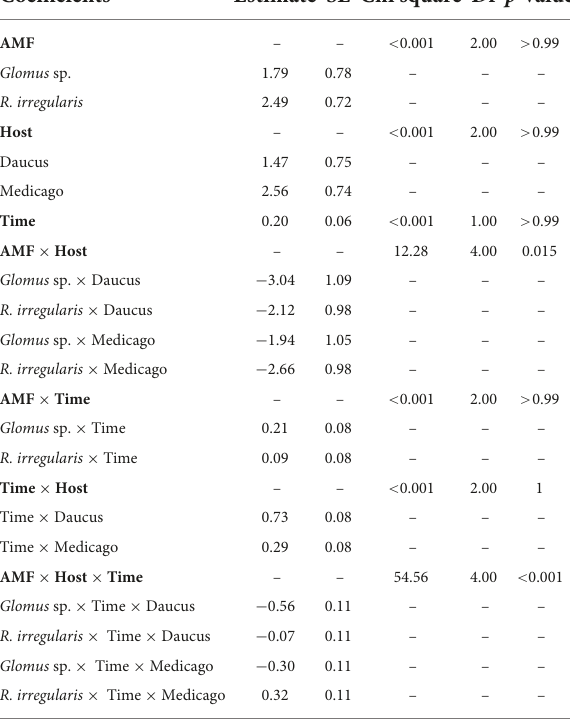
TABLE 1 Cumulative link mixed models comparing the progression of four pairs of host (Medicago, Daucus ) /AMF ( R. irregularis, Glomus sp.) through the six stages of symbiosis development as a function of a three-way interaction between host, AMF, and time (0–12 weeks). Coefficients